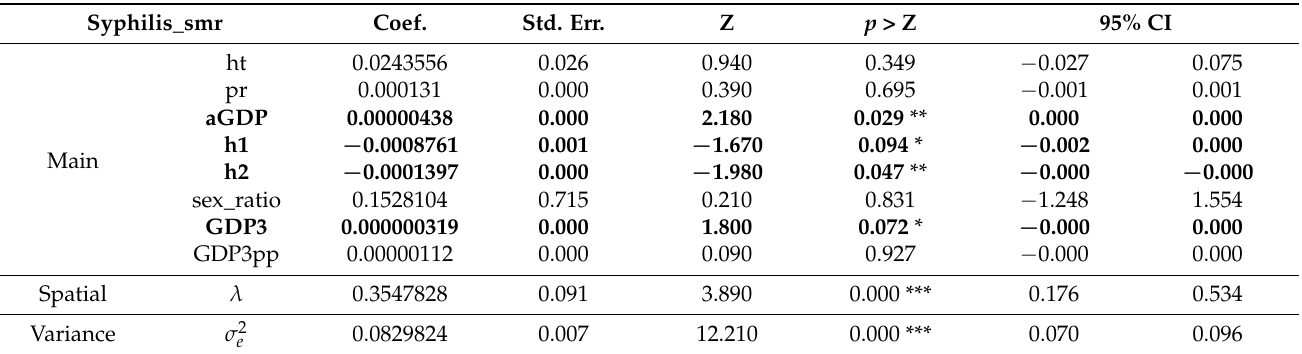
Table 8 illustrated that there was a positive correlation between SMR of syphilis and GDP per capita ( Z = 2.180, p = 0.029) and tertiary industry GDP ( Z = 1.800, p = 0.072) in Ningxia, indicating that higher GDP per capita and tertiary industry GDP adversely affect the incidence of syphilis. Moreover, the SMR of syphilis in Ningxia was negatively correlated with the number of healthcare facilities ( Z = − 1.670, p = 0.094) and the number of healthcare personnel ( Z = − 1.98, p = 0.047), which implied that the adequate medical resources was conducive to the prevention and control of syphilis. Moreover, the coef- ficient of spatial autoregression was λ = 0.355 ( p < 0.001), which demonstrated that the aforementioned influencing factors, were also affected by the neighborhood levels. Table 8. The regression results of spatial error